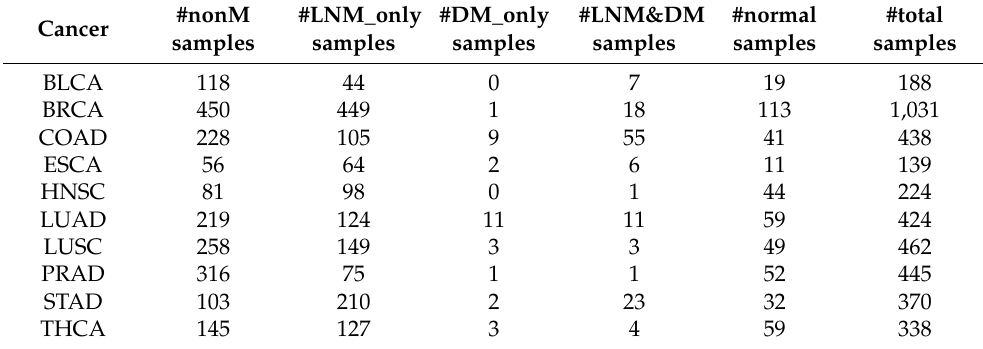
The RNAs of 4 biotypes (miRNAs, lncRNAs, mRNAs, and pseudogenes) obtained after removing those with low-expressions are shown in Table 2. The number of miRNA– RNA pairs left after each filtering process is shown in Table 3. The correlations of the miRNA–RNA pairs were used in our study to predict metastasis and